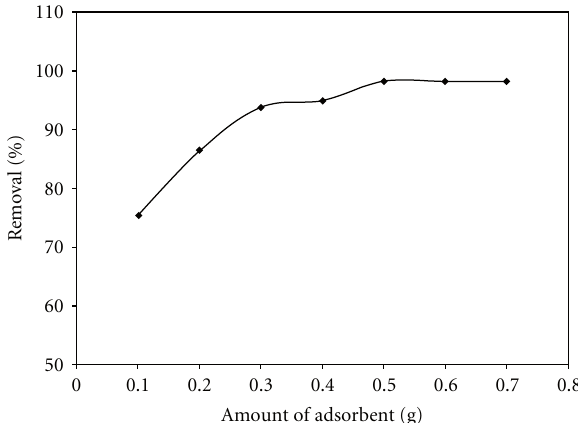
Amount of adsorbent F 4: Effect of biosorbent dosage level on the biosorption